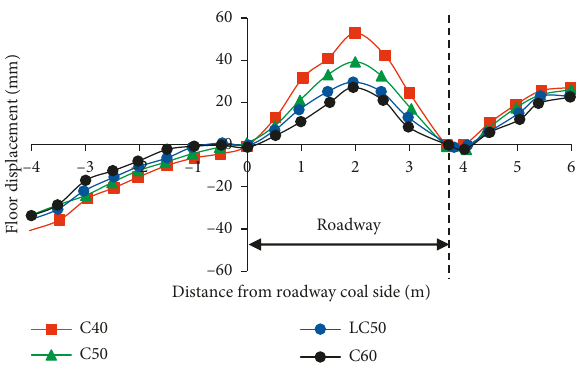
Figure 24: Deformation curve of the